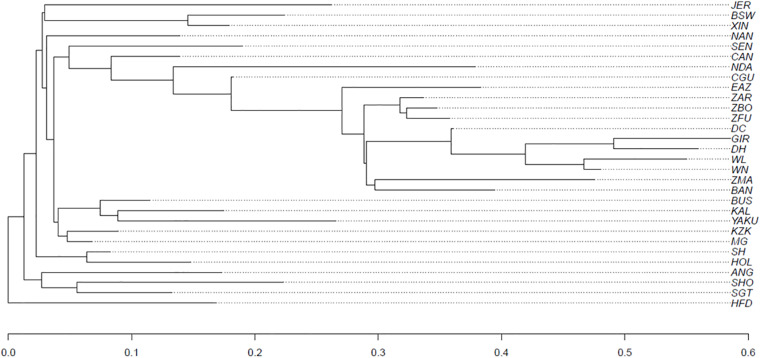
Genomic population tree comparing the genomic distance between 32 cattle breeds*. (*see Supplementary Table 1 for abbreviations).